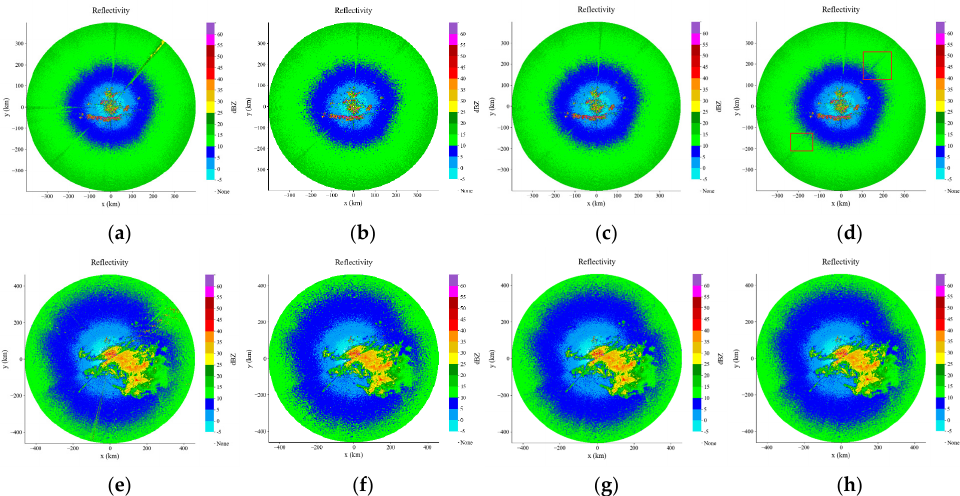
Figure 7. Suppression results of three models for electromagnetic interference. ( a ) Raw data; ( b ) products generated by suppression of electromagnetic interference in ( a ) after UNet identification; ( c ) products generated by suppression of electromagnetic interference in ( a ) after ResNet identification; ( d ) products generated by suppression of electromagnetic interference in ( a ) after DeepLab V3+ identification; ( e ) original image; ( f ) products generated by suppression of electro- magnetic interference in ( e ) after UNet identification; ( g ) products generated by suppression of electromagnetic interference in ( e ) after ResNet identification; ( h ) products generated by suppression of electromagnetic interference in ( e ) after DeepLab V3+